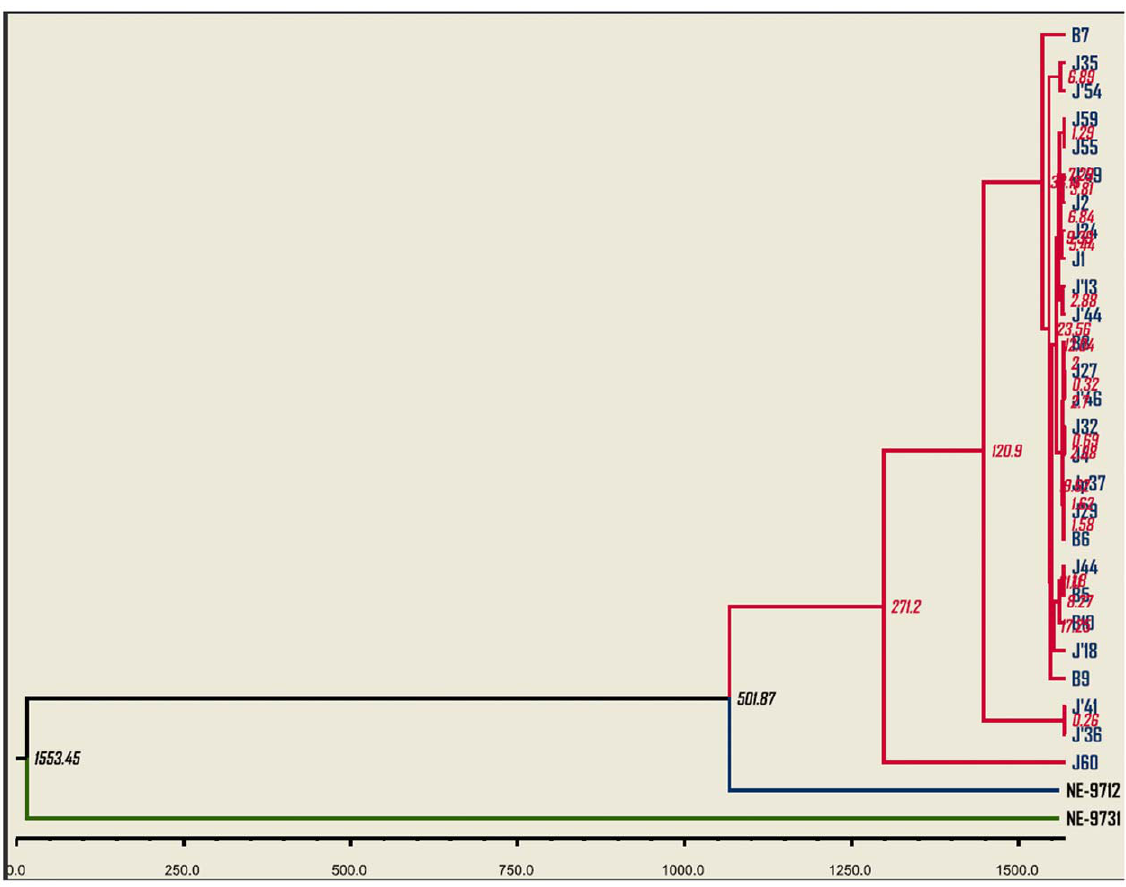
Figure 6. Maximum clade credibility tree based on segment 10 of LNV-1 and LNV-2 prototype isolates and including the 27 LNV isolates obtained from mosquitoes in 2005. The axis shows the estimated dates for most recent common ancestors as years before 2005. NE- 9712 (LNV-NE9712) and NE-9731 (LNV-NE9731) are prototype strains of LNV serotypes 1 and 2, respectively. Values at the nodes are those for the most recent common ancestor of segment 10.